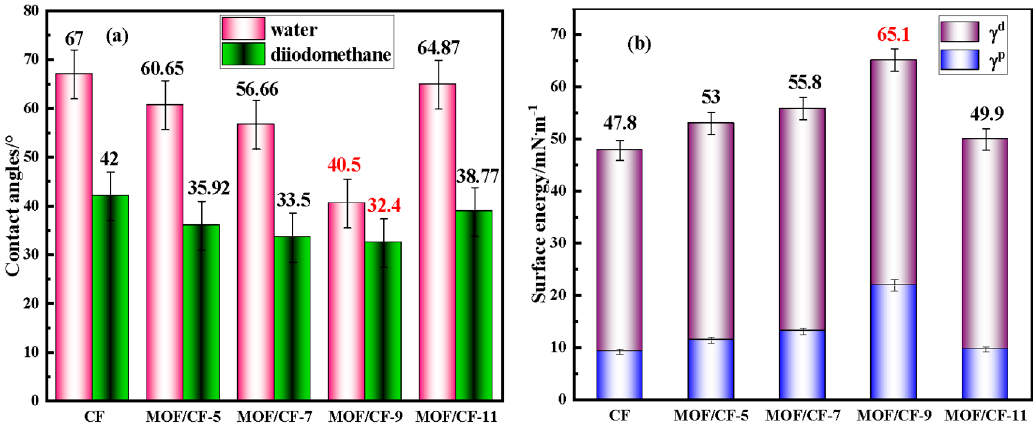
Figure 6. Contact angles and surface energy of MOF/CF ( a ) contact angle; ( b ) surface energy .